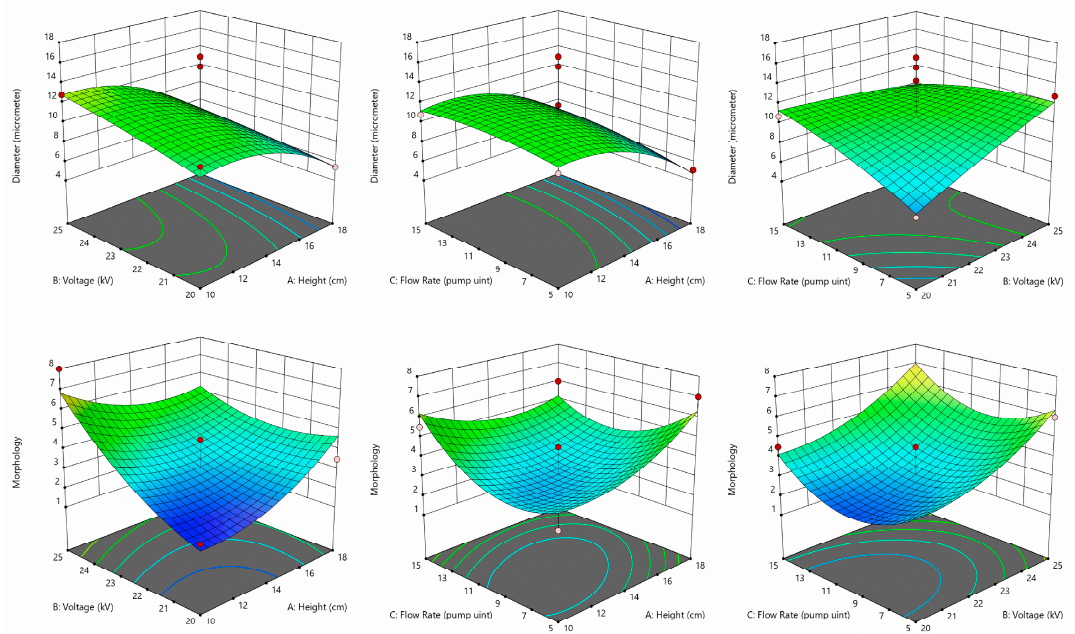
Figure 2. Response surface plots that show the effect of variables on the size (upper panel) and morphology (lower panel) before model reduction. The points which encompass the coordinates are displayed. Dark red dots: design points above predicted value; and pink dots: design points below predicted value.